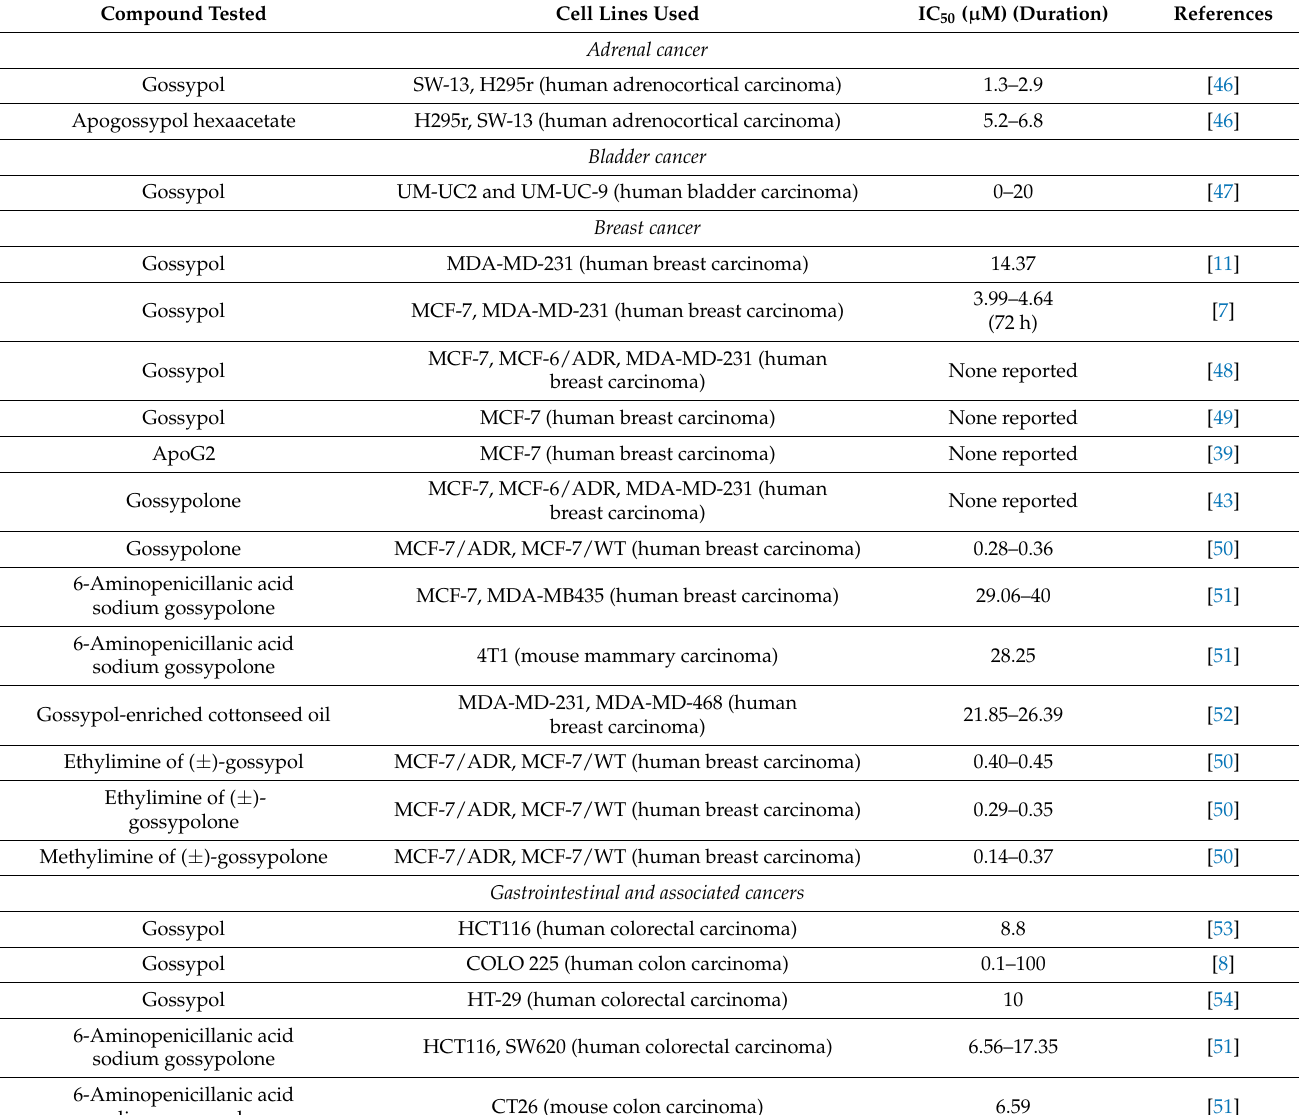
Table 3. Gossypol and their derivative’s activities against different types of cancer cell lines in